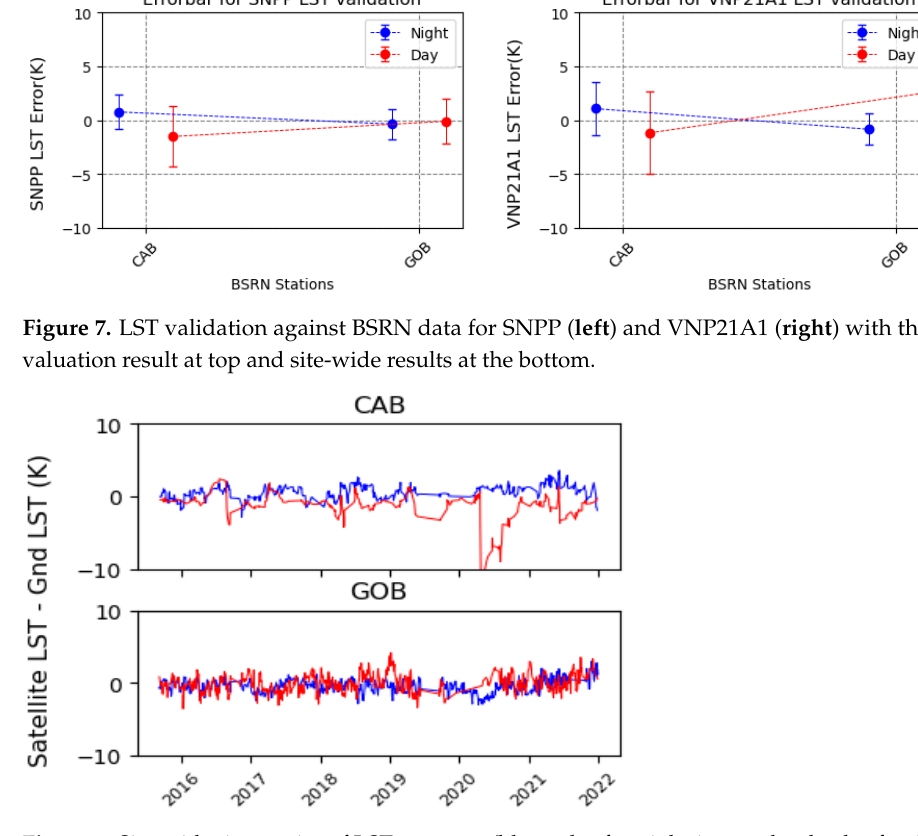
Figure 8. Site-wide time series of LST accuracy (blue color for nighttime and red color for daytime).